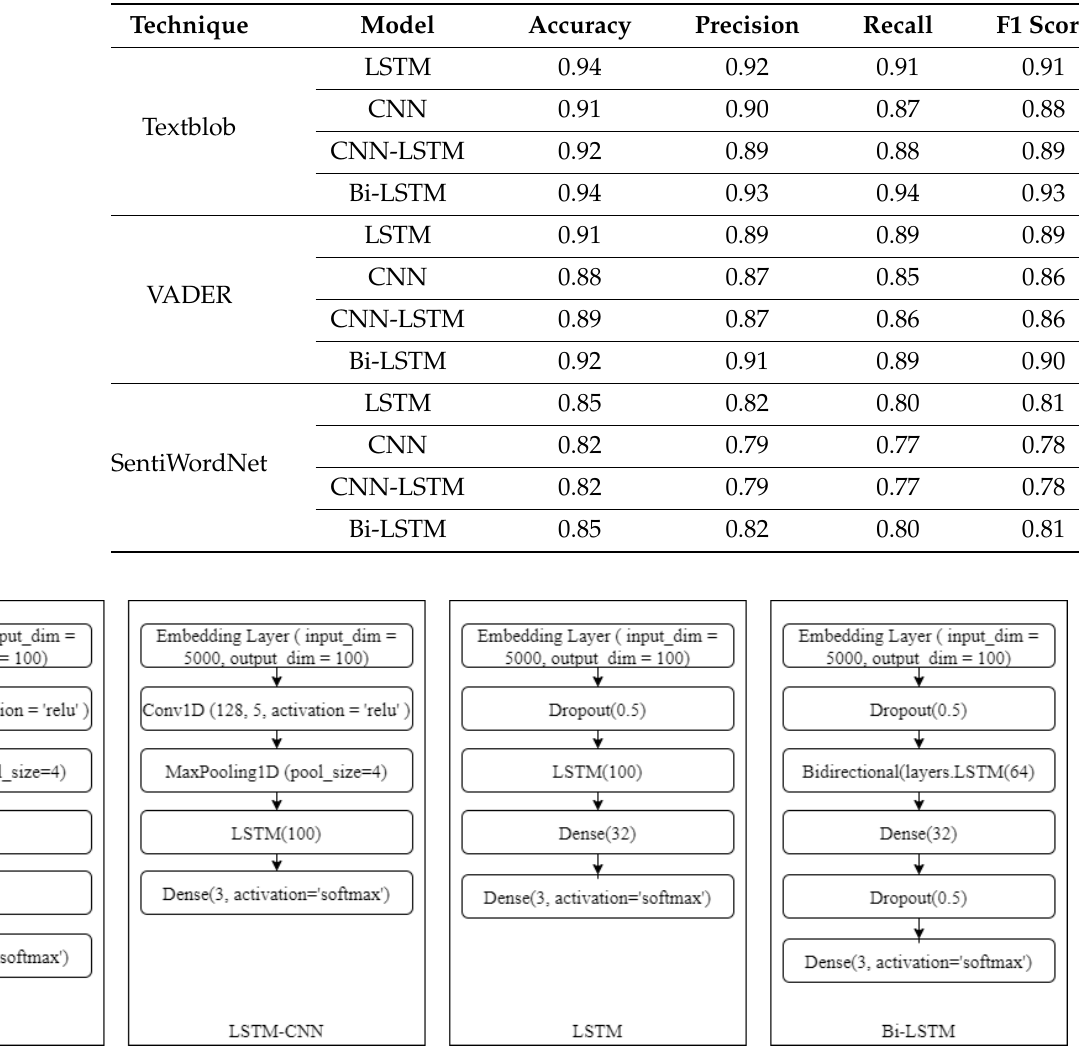
Table 19. Performance of deep learning models with each lexicon technique.